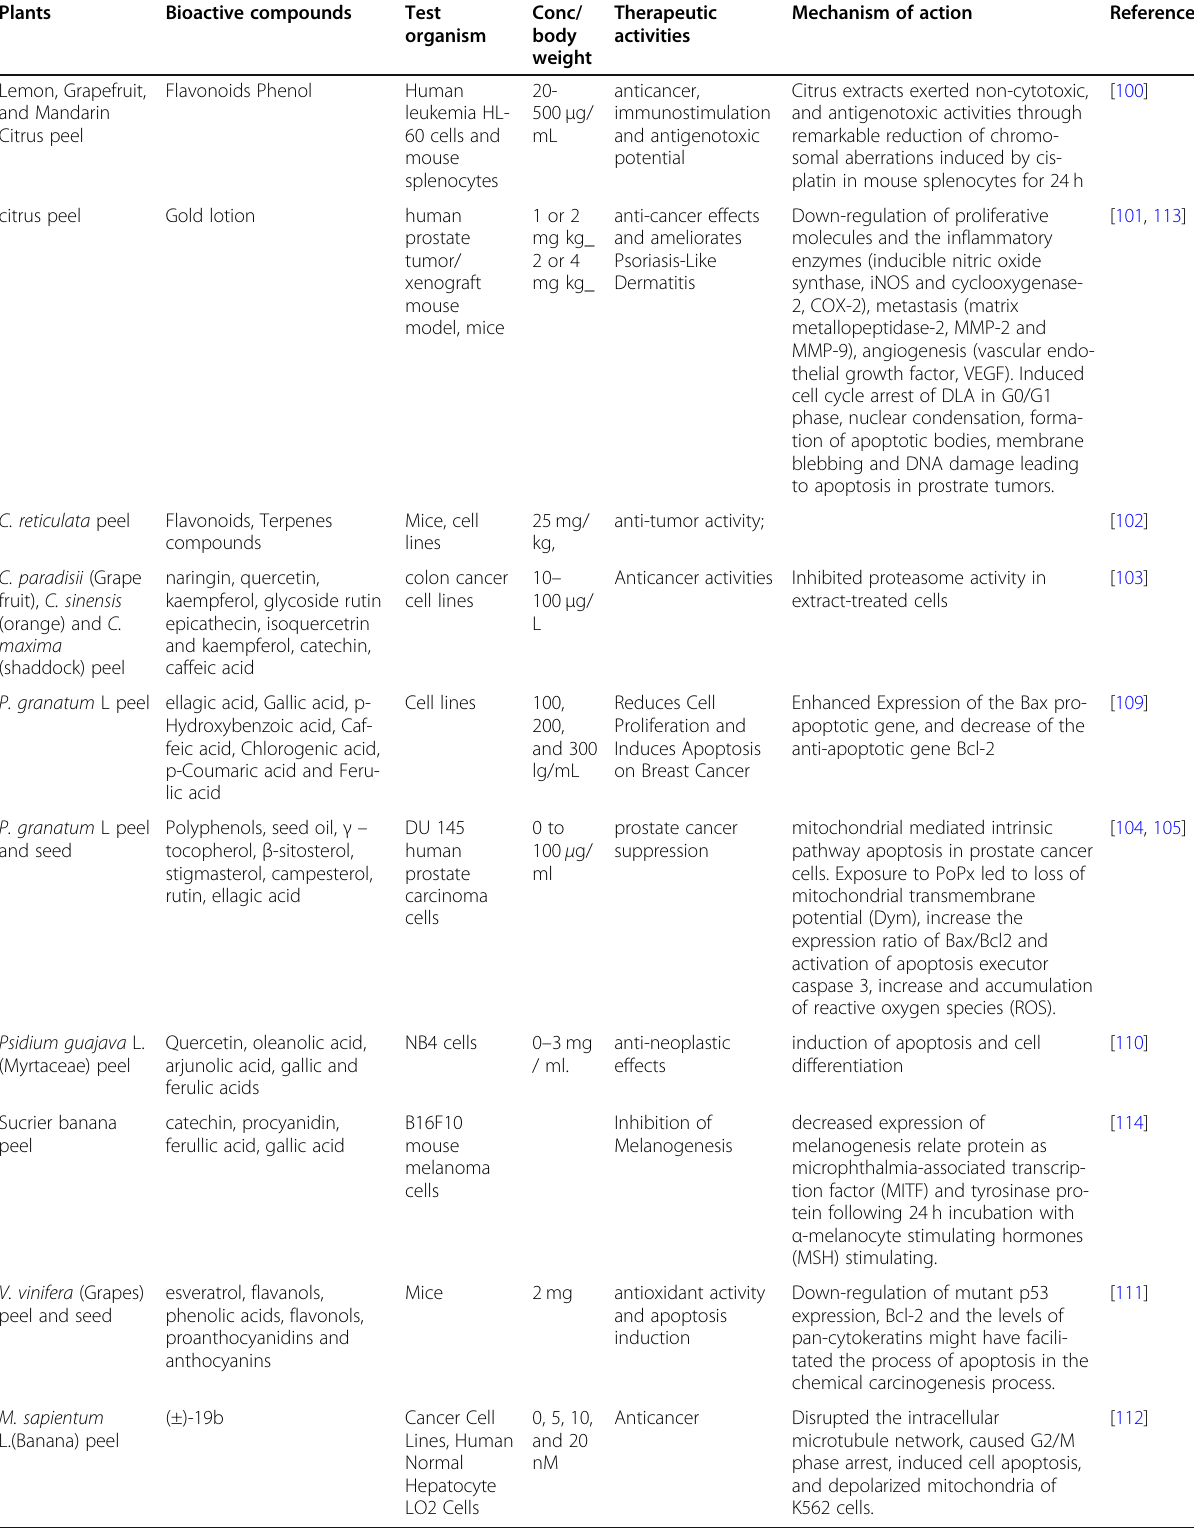
Table 6 Anticancer activities of some peels and seed extracts